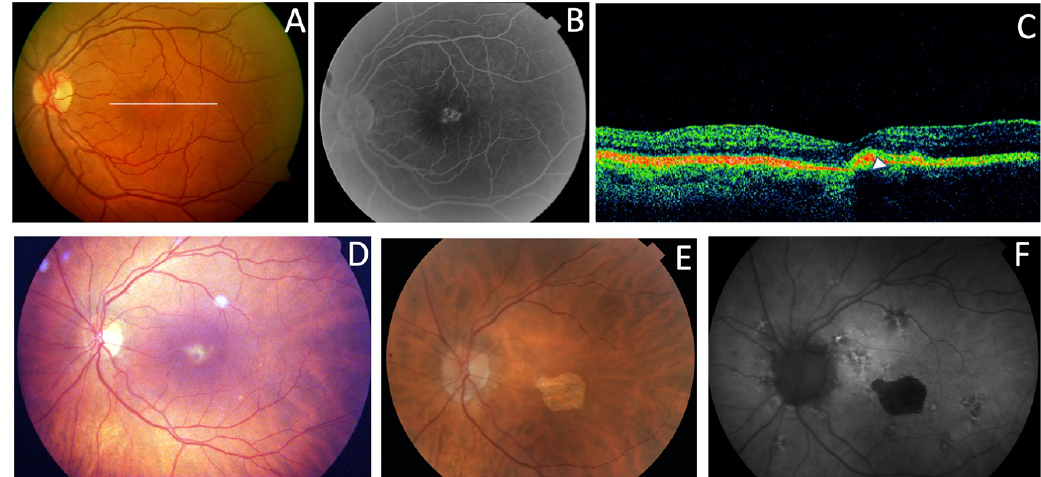
Figure 3. The clinical features of AVMD from families 1 (p.Arg46Ter) and 6 (p.Val209Ile). ( A ) The fundus appearance with the typical small yellow foveal deposits, ( B ) fluorescein angiography (FA) shows the hyperfluorescence produced by a window defect, and ( C ) spectral-domain optical coherence tomography (SD-OCT) shows the subfoveal hyper-reflective deposit (white arrow) from patient F1-II-2. ( D ) The ocular fundus appearance from a patient aged 56 years (F6-I-5) with a pigmented foveal dot surrounded by a yellow halo. ( E , F ) The fundus and autofluorescence after 14 years show macular atrophy.